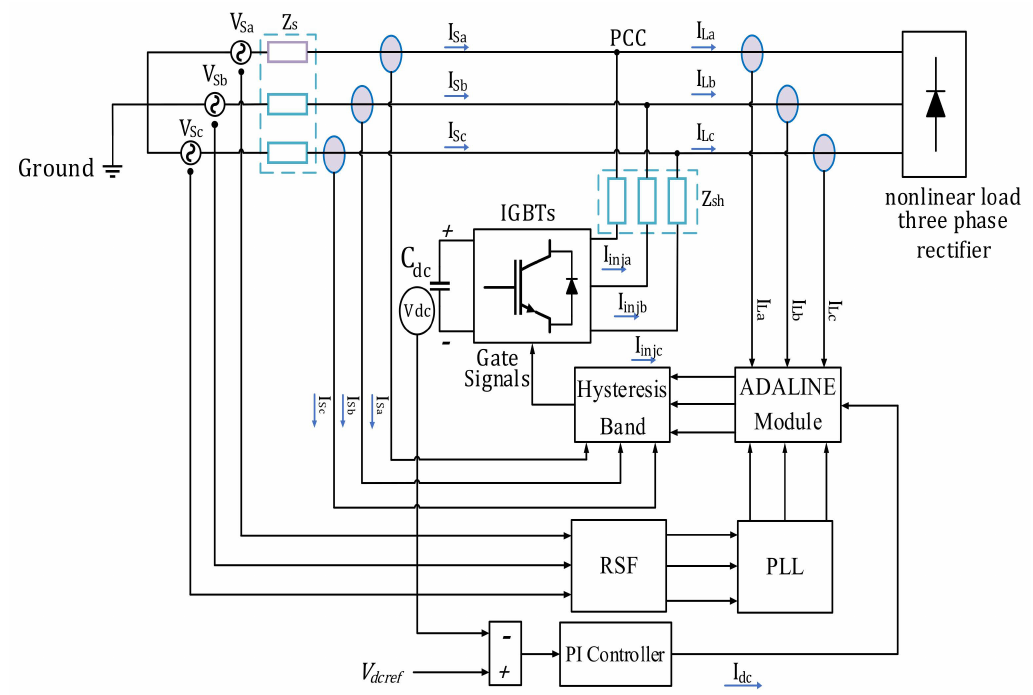
Figure 1. The control system of the shunt active power filters (SAPF).